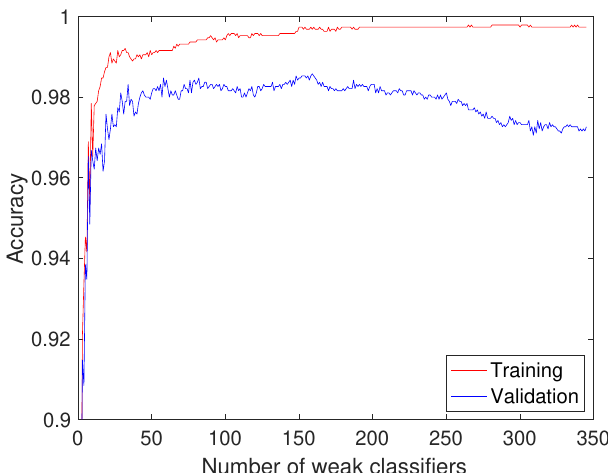
Figure 7. Calculated accuracy of the classifier when varying the number of weak